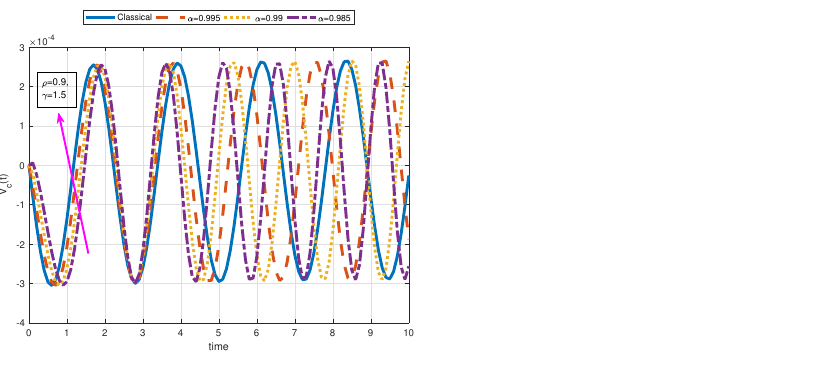
Figure 5. This figure corresponds to the function V c ( t ) with an oscillatory source for different values of α , ρ , and γ in order to show the effect of α on solution curves when R = 1 Ω , C = 10 F, e 0 = 10 V, and θ = 60 Hz, V c ( 0 ) = 10.